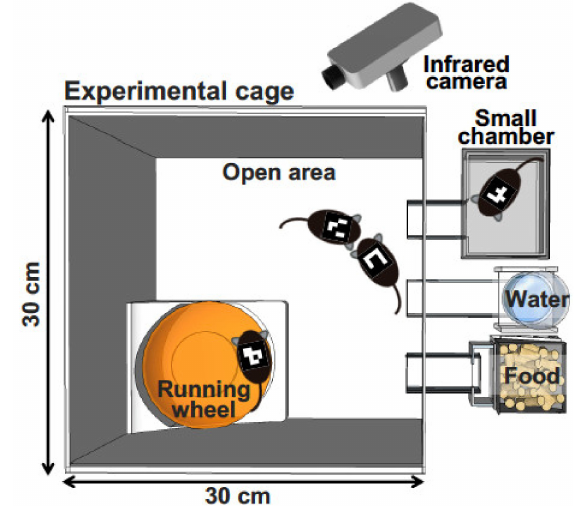
Figure 1. Schematic representation of behavioral analysis under group-housing conditions. Adult male mice are individually tagged with a mouse ID on their back. An infrared camera takes an image for several days. The software recognizes the ID of each mouse and records the X–Y